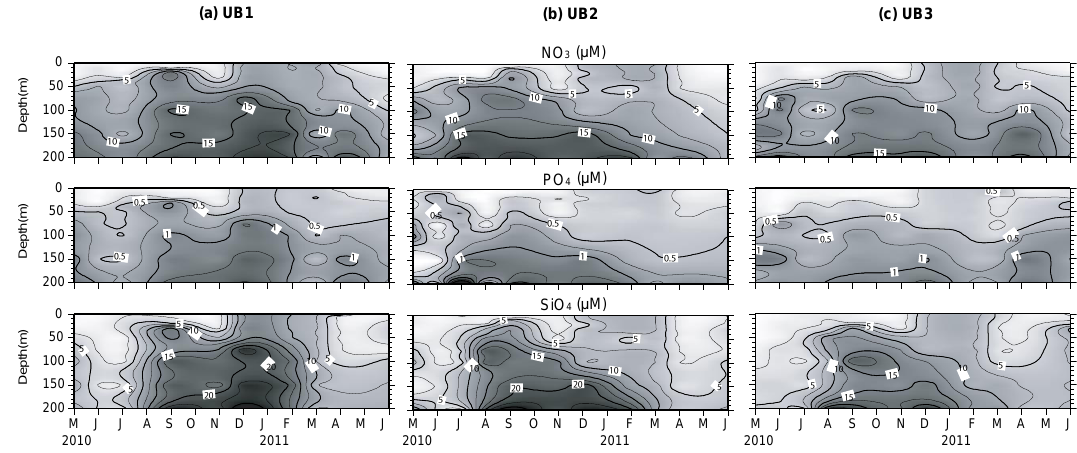
Fig. 4. Contour plots of chemical parameters (nitrate (NO 3 ) , phosphate (PO 4 ) , and silicate (SiO 4 ) ) observed at the three stations during our study Figure 4. Contour plots of chemical parameters [nitrate (NO (SiO )] observed at the three stations during our study period. 4 4